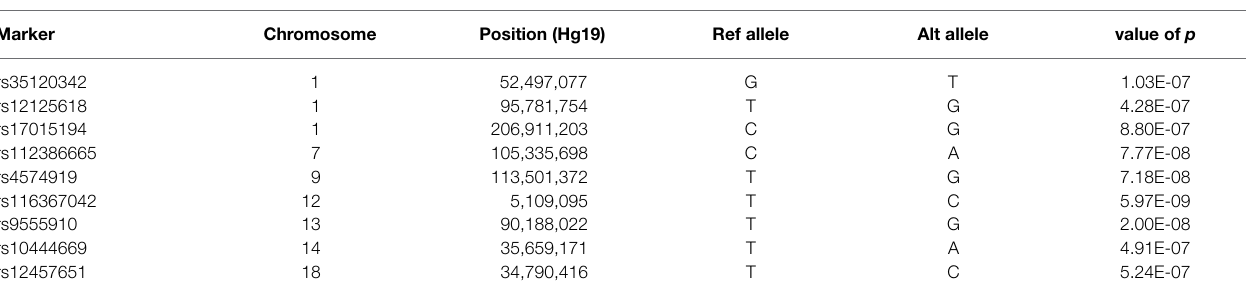
TABLE 2 | Genome-wide and suggestive associated loci.